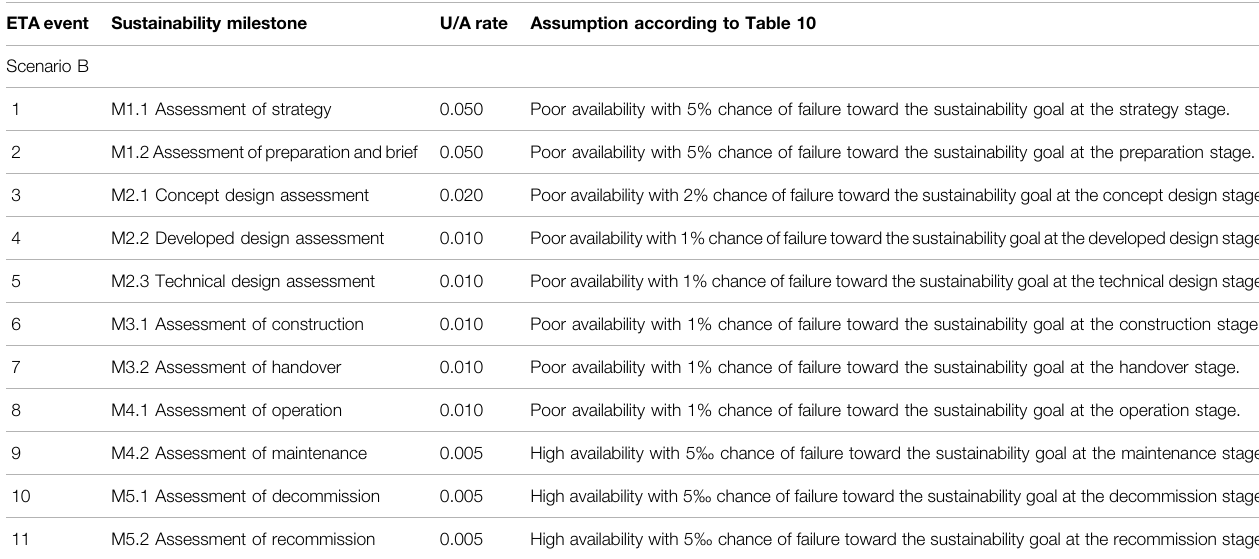
TABLE 12 | Unavailability upon megaproject sustainability in the ETA experiment: Scenario B. ETAevent Sustainability milestone U/A rate Assumption according to Table